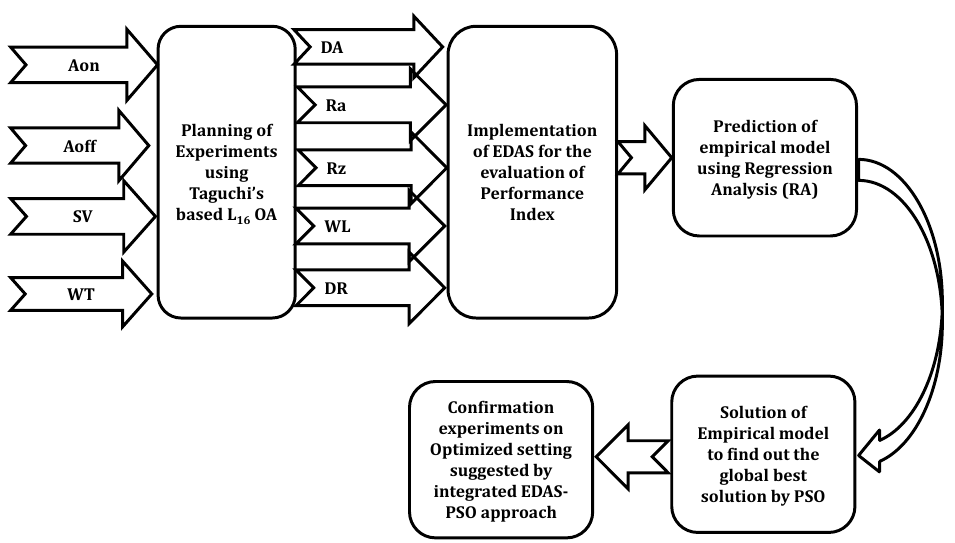
Figure 2. Methodology adopted in the present research work .